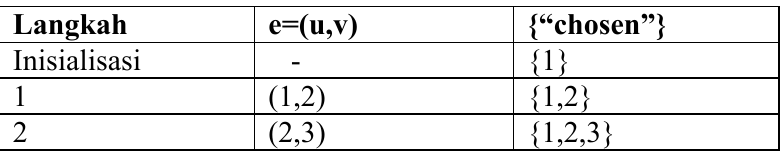
Table.1 Steps of a graph minimum spanning tree has thick